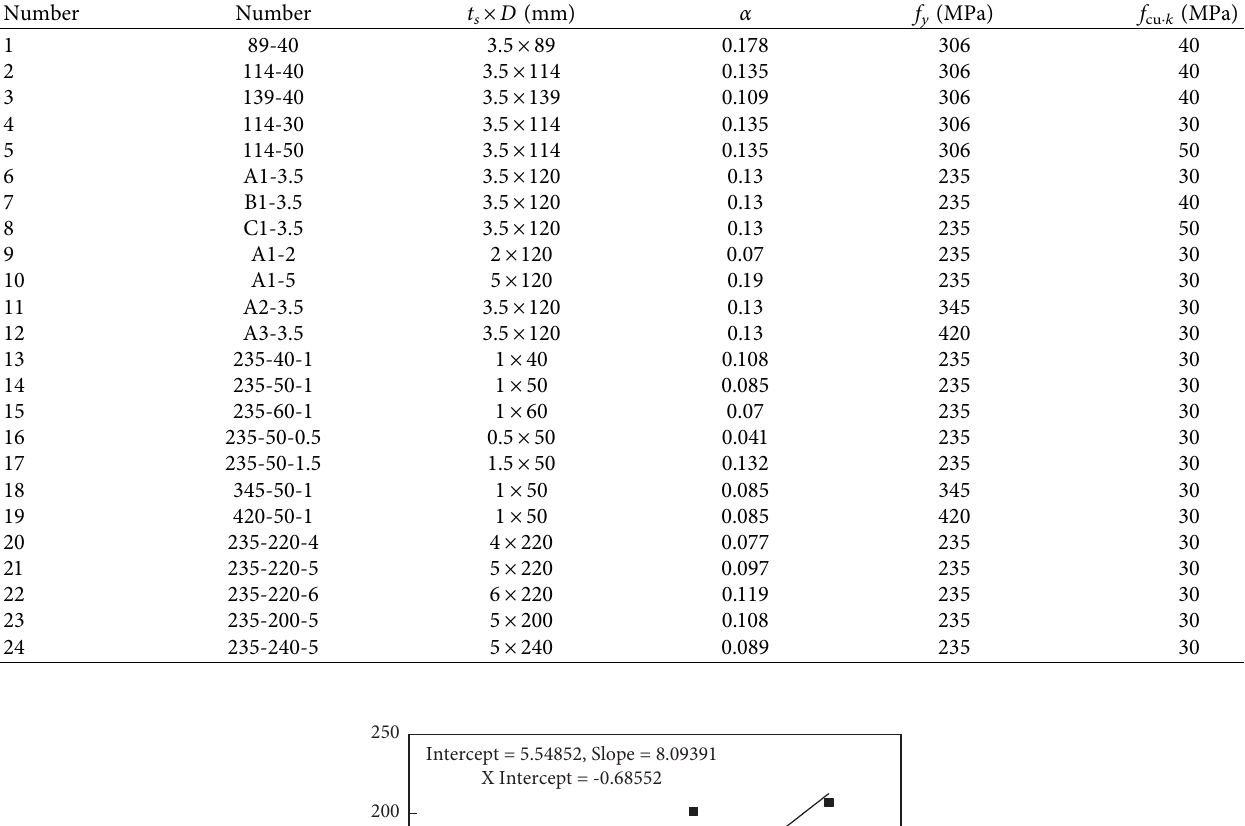
Table 8: Simulation model summary.